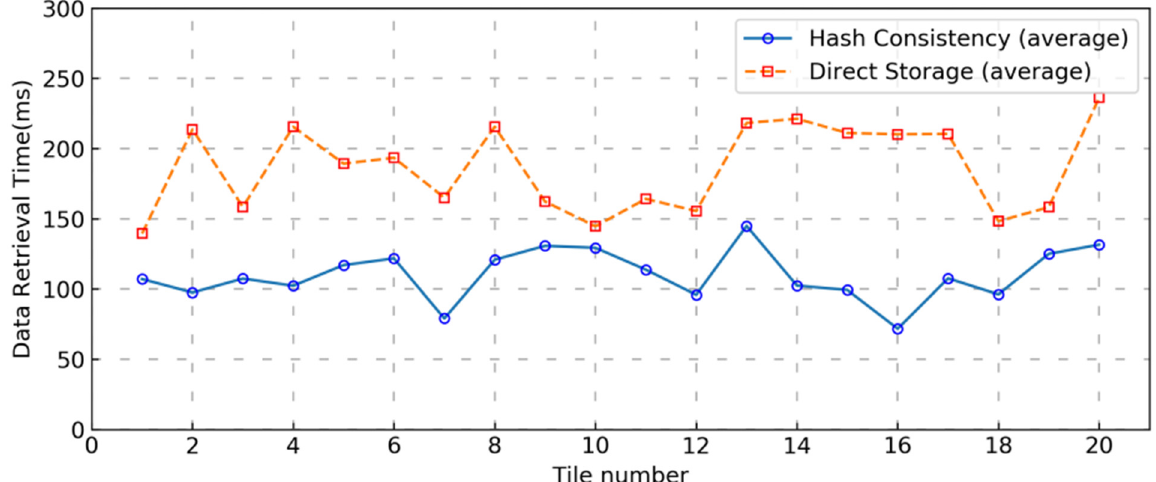
Figure 8. Comparative analysis of server performance using two different storage schemes.